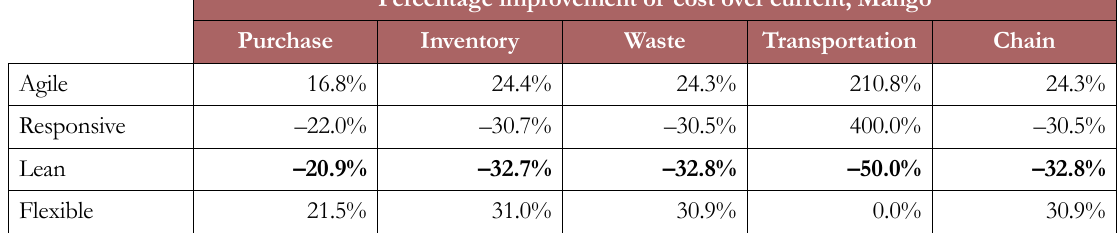
Table 9a. Percentage Change cost for Mango